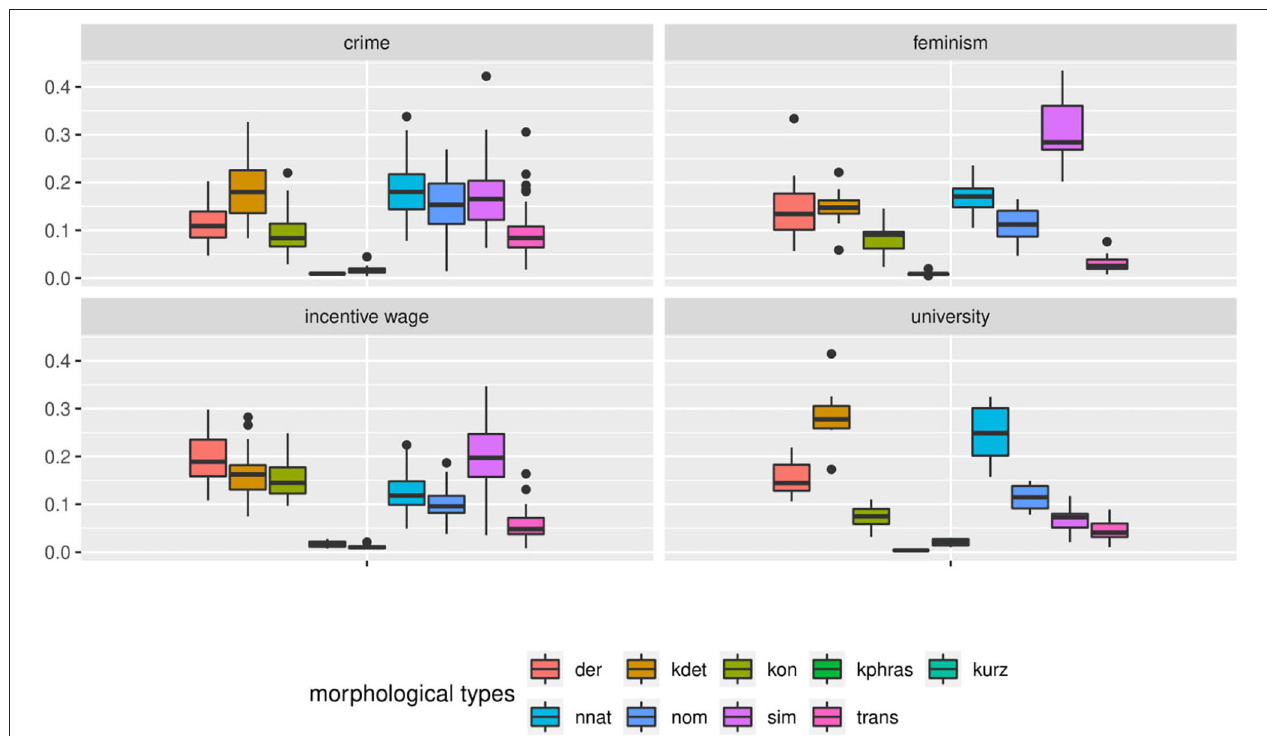
FIGURE 6 | The frequency of morphological types of nouns in Falko varies greatly when the distribution across individual documents is considered. Even some of the most frequent types, like simplex nouns sim in the incentive wage topic, barely occur in some texts. It also appears as if certain topics elicit more clearly defined distributions ( university and feminism ), while the overlap between boxes is much larger in the other two topics, particularly so in the crime topic. This may be due to higher random variability or an artifact from a lumping of different speaker, register, or text type